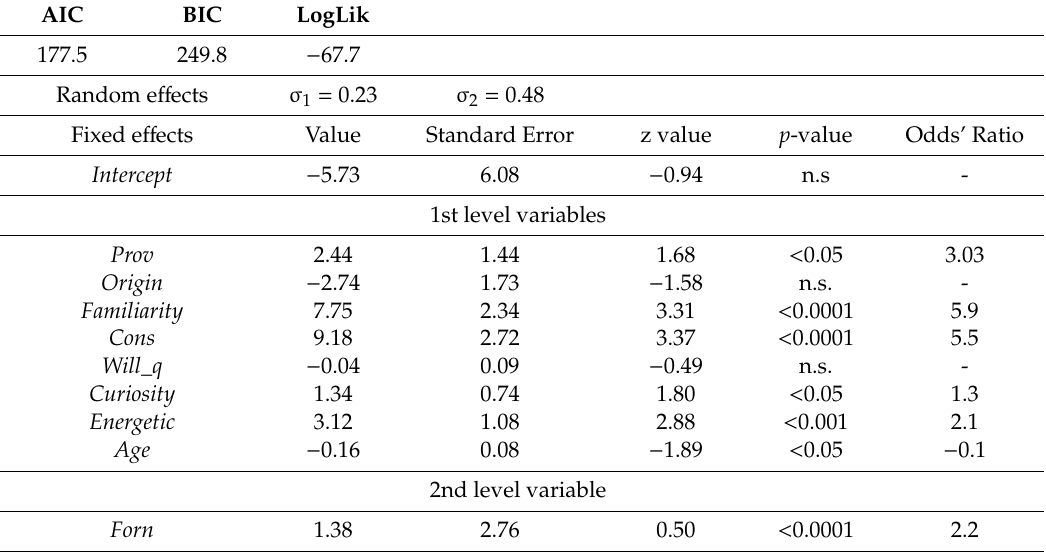
Table 7. Parametric estimation results for the full model Equation